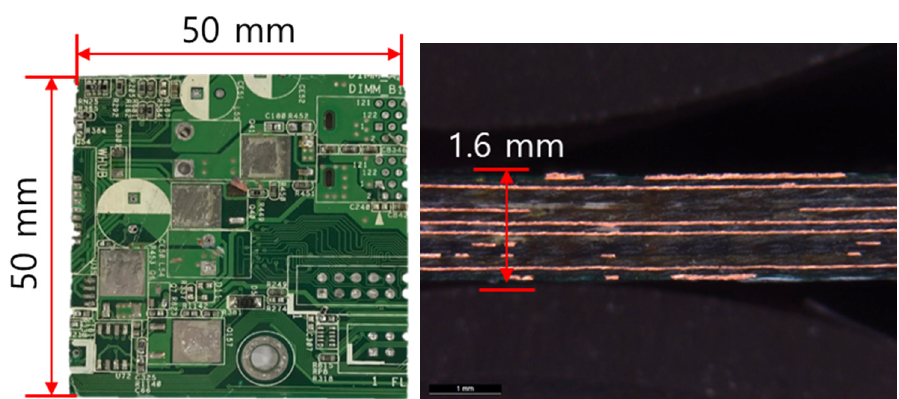
Figure 2. Front and side images of waste shredded PCB with EC disassembled for copper separation from waste PCB.